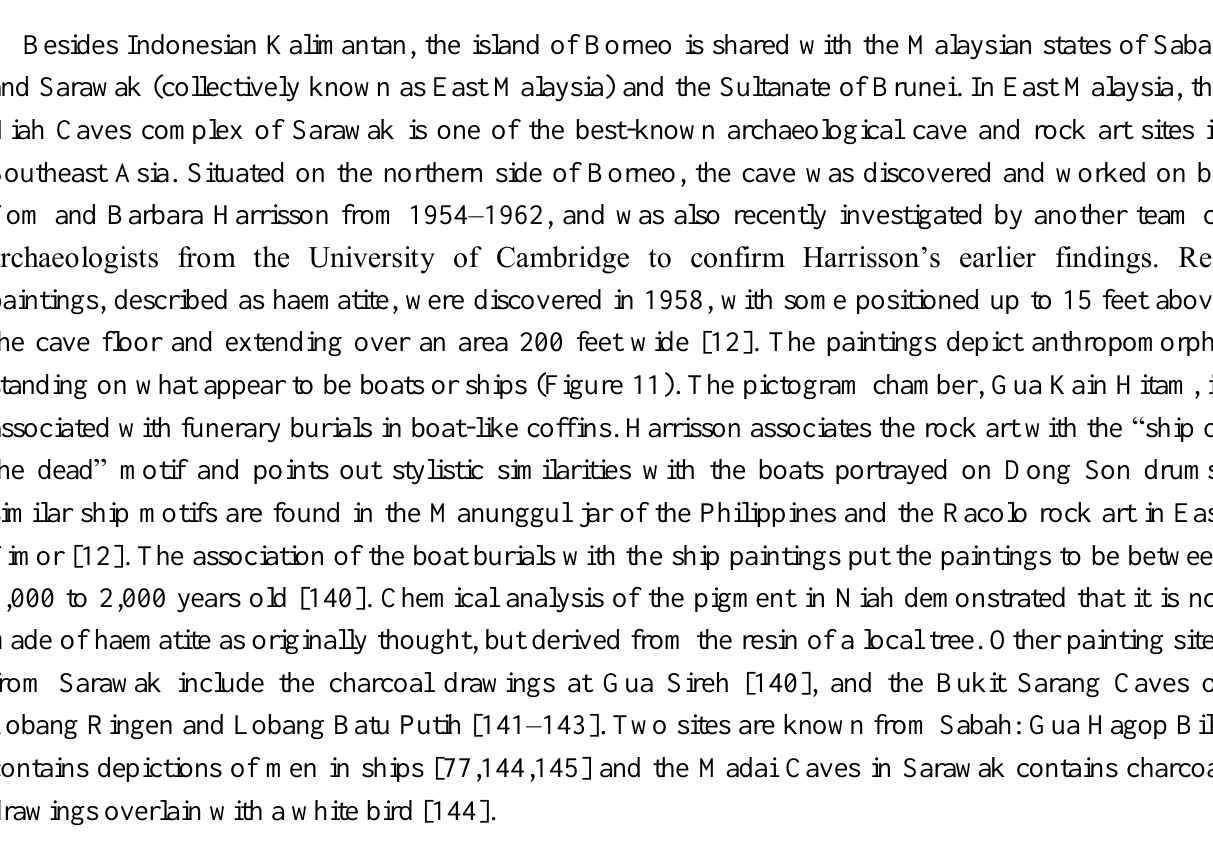
Figure 11. The “ships of the dead” of Gua Kain Hitam in Sarawak are associated with boat-shaped coffins found in the same cave. Photo: Nicholas